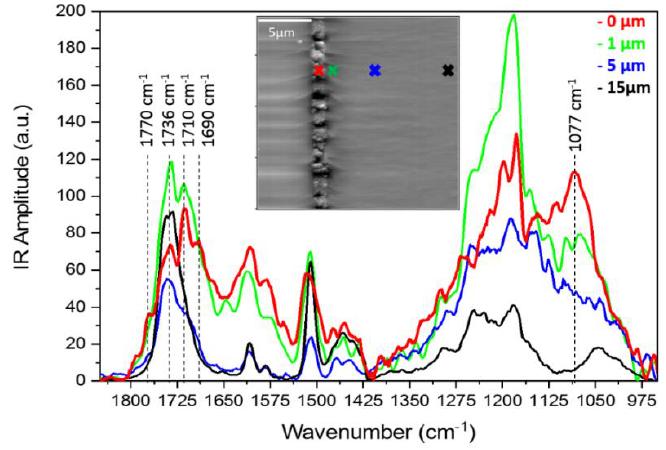
Figure 7. AFM-infrared spectroscopy (AFM-IR) spectra from point measurements shown in the inset AFM topography image of the cross-sectional surface of EP1/HydBo/EP2 model sample.